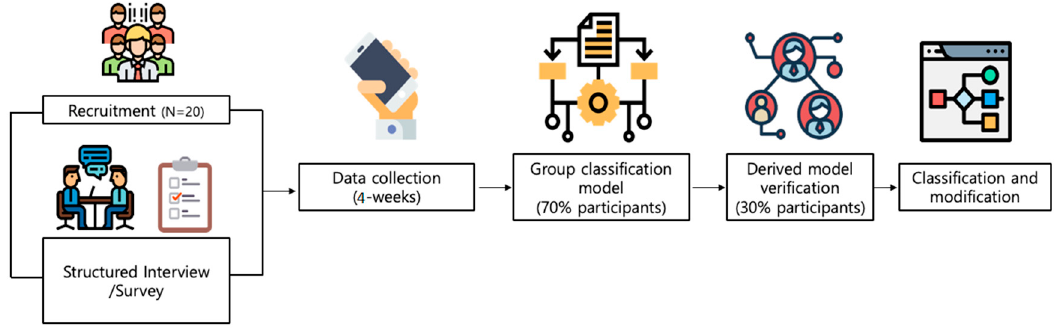
Figure 1. Study procedure of depression group classification: 20 participants for four weeks.